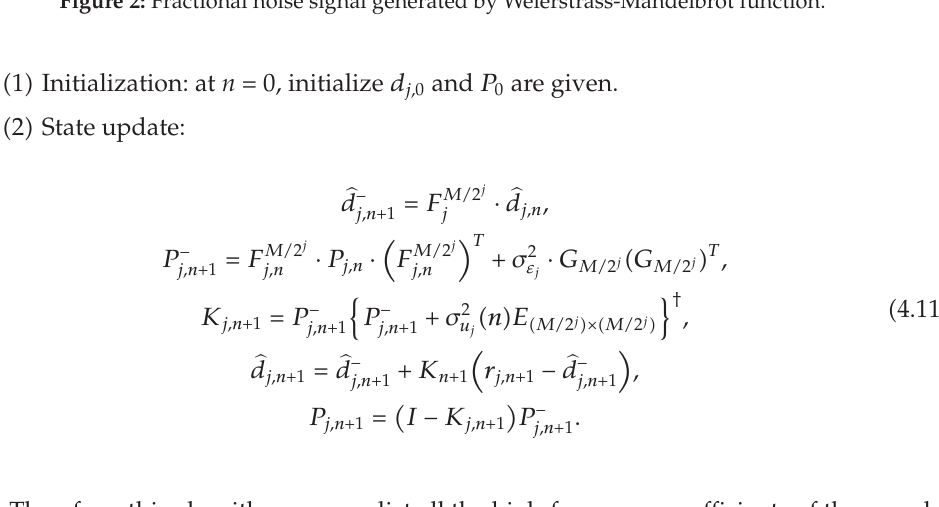
Figure 2: Fractional noise signal generated by Weierstrass-Mandelbrot